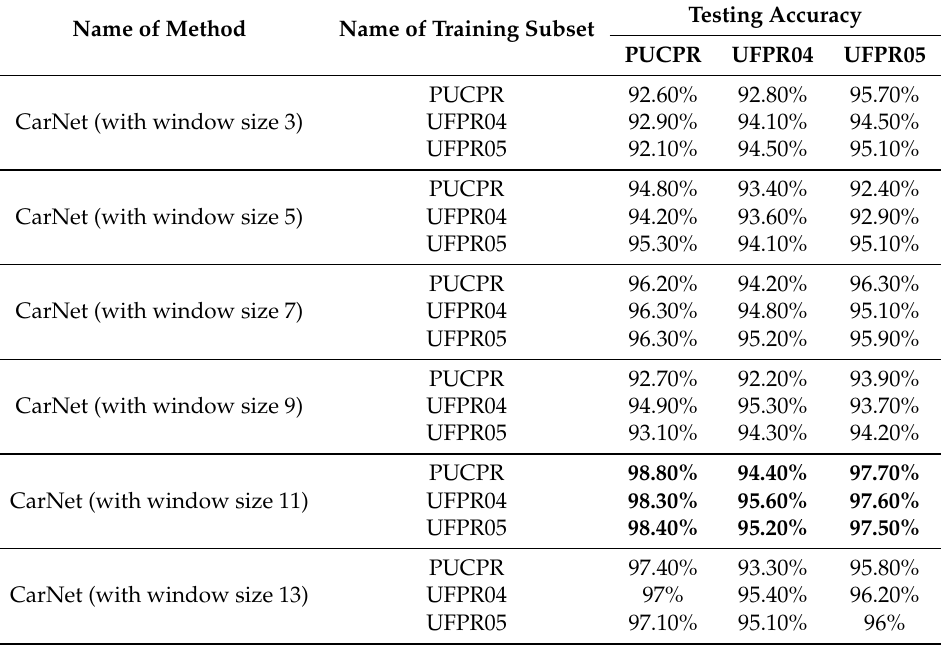
Table 8. Comparison of testing accuracies for experiments with different window